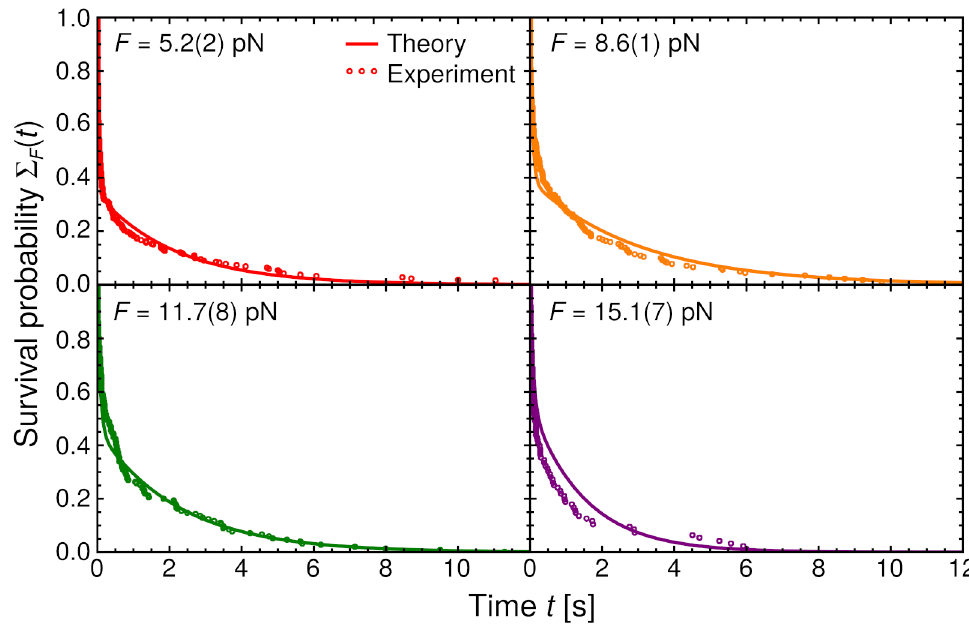
Fig 4. Bond survival probability S ( t ) versus time t for four different forces F . Theory results are shown as curves, and F the corresponding experimental data [11] as symbols.